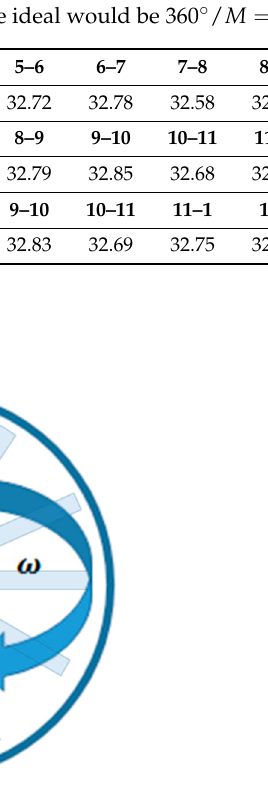
Figure 5. Schematic setup of the BTT system retrieved from the available data acquired from the three probes (optical sensors), assuming a clockwise turbine rotation.